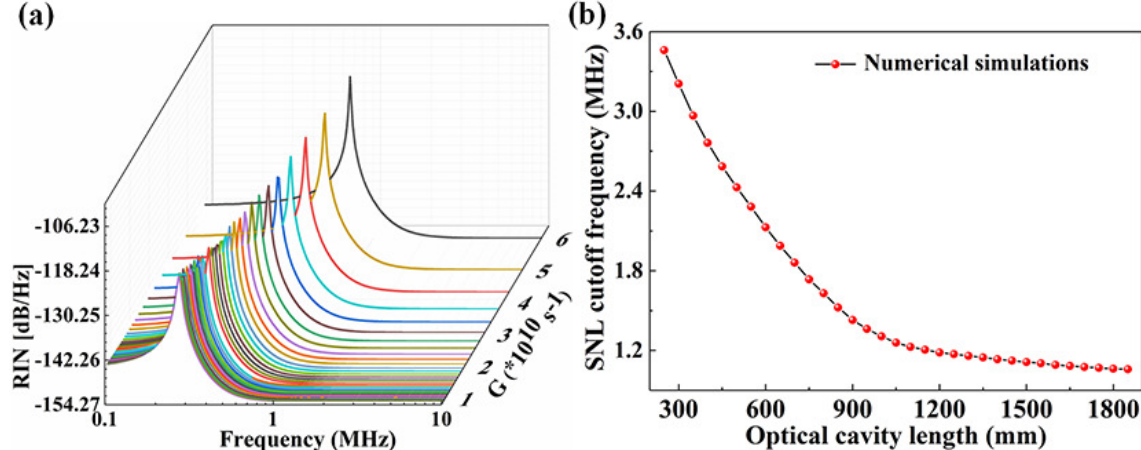
Figure 24. ( a ) Numerical simulations of the intensity noise spectra of the laser with different SER G . ( b ) Theoretical prediction of the SNL cutoff frequency versus length L of resonator [35]. Reprinted with permission from [35] c (cid:13) The Optical